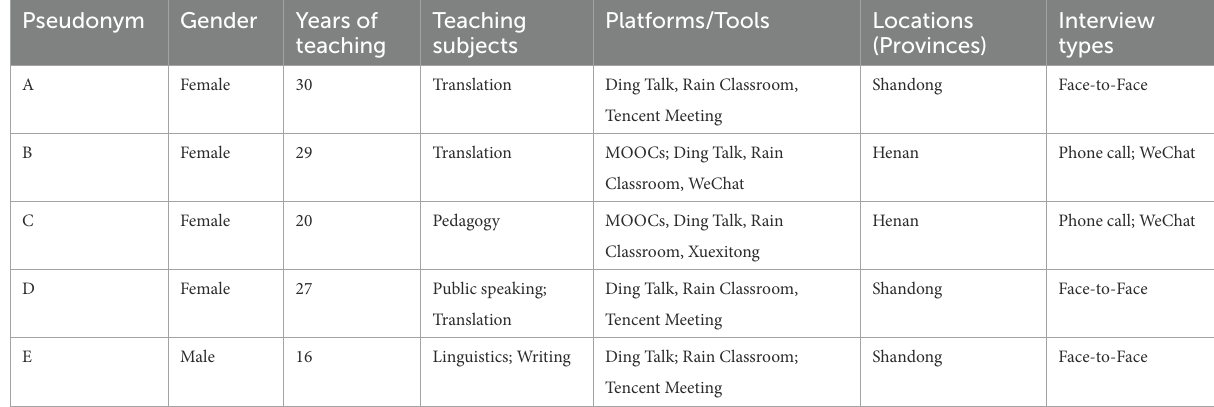
TABLE 2 Demographic information of interviewees ( N =